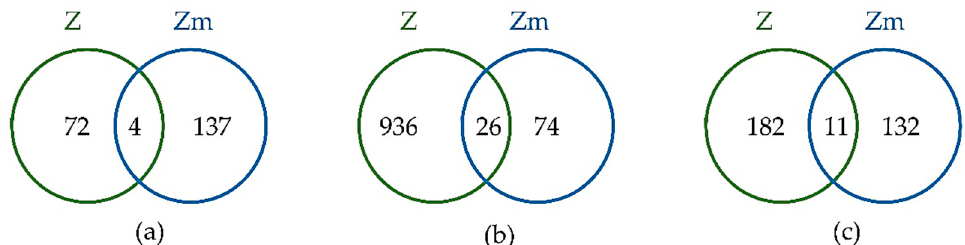
Figure 6. Venn diagram comparing the differentially abundant proteins between E. gracilis Z-and Zm-strains when treated with the heavy metal Hg ( a ), Cd ( b ), and Pb ( c ). The intersection of the sets represents the differentially abundant proteins common to both strains for the respective heavy metal treatment.